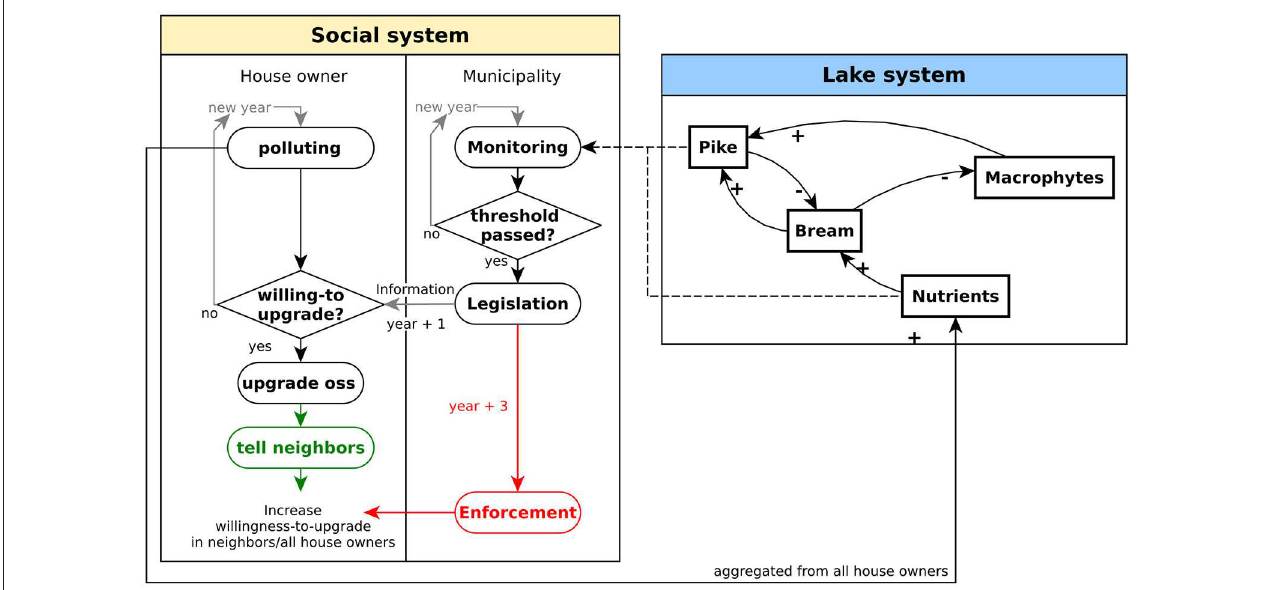
FIGURE 2 | Conceptual graph of our hybrid model with the social system represented by a flow chart and the lake system by a causal-loop diagram. The subsystems are connected via the monitoring of the municipality and the nutrient release from private house owners with insufficient onsite-sewage systems (OSS). The colored processes for the social actors show optional, additional responses that are explored and compared in our model analysis.